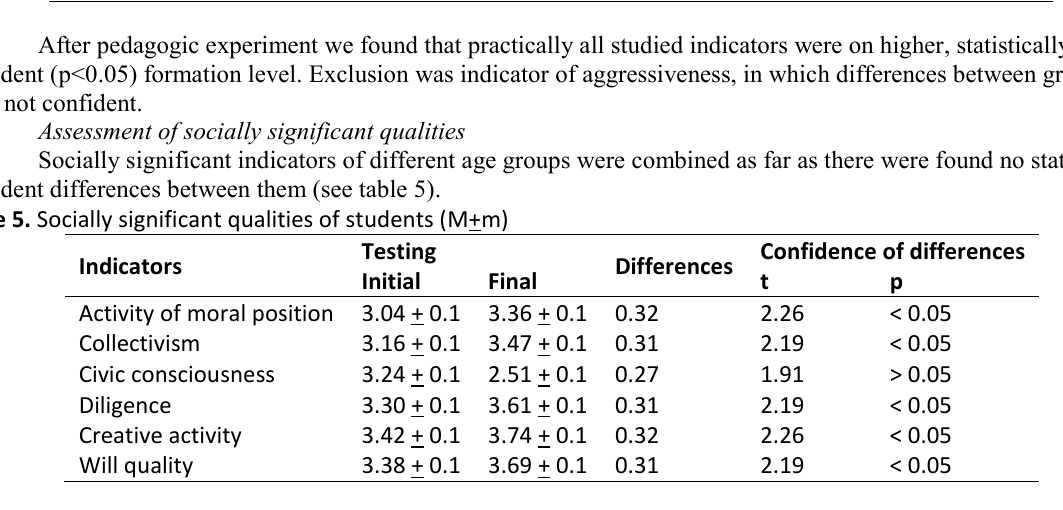
Emotional stability Concentration of attention